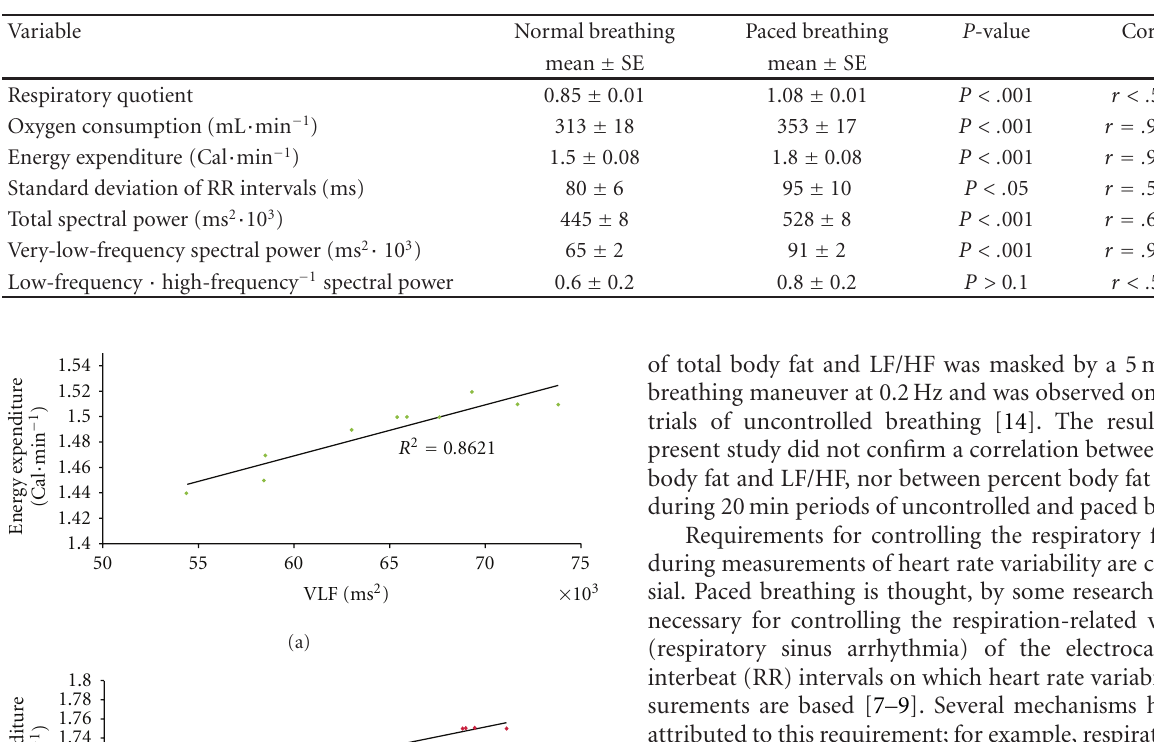
Table 2: Comparison of uncontrolled normal and paced breathing conditions.